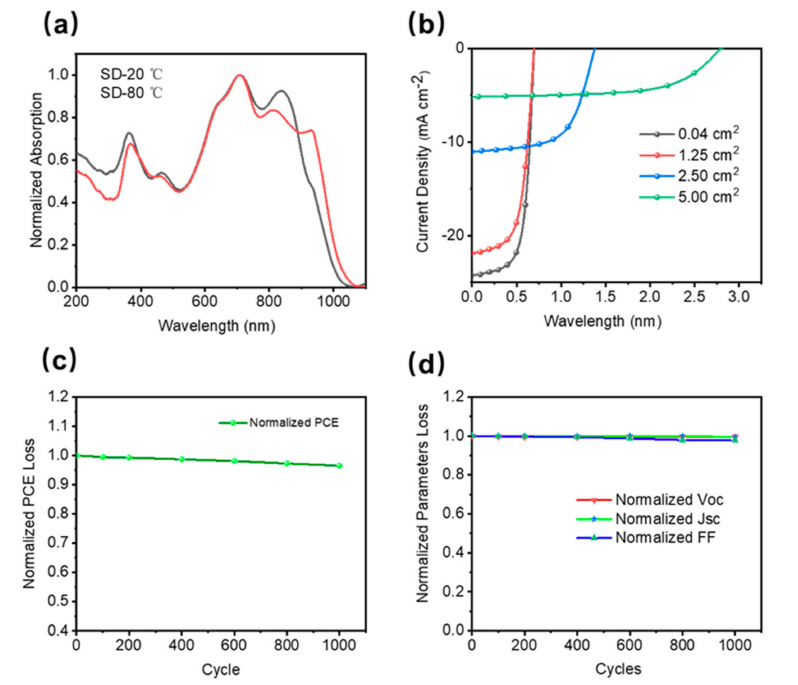
Figure 2. Large-area flexible solar cell structure: PET(Ag-grid)/ZnO/, PTB7- Th:COi8DFIC:PC 71 BM/MoO 3 /Ag ( a ) Normalized Absorption of different slot-die temperature. ( b ) 0.04~5 cm 2 large-area rigid/flexible solar cells/modules with different areas The JV features. ( c ) Bend test normalized PCE characteristics. ( d ) Bend test normalized electrical loss characteristics. (Average performance is statistically derived from testing the same batch of devices. The margin of error is within